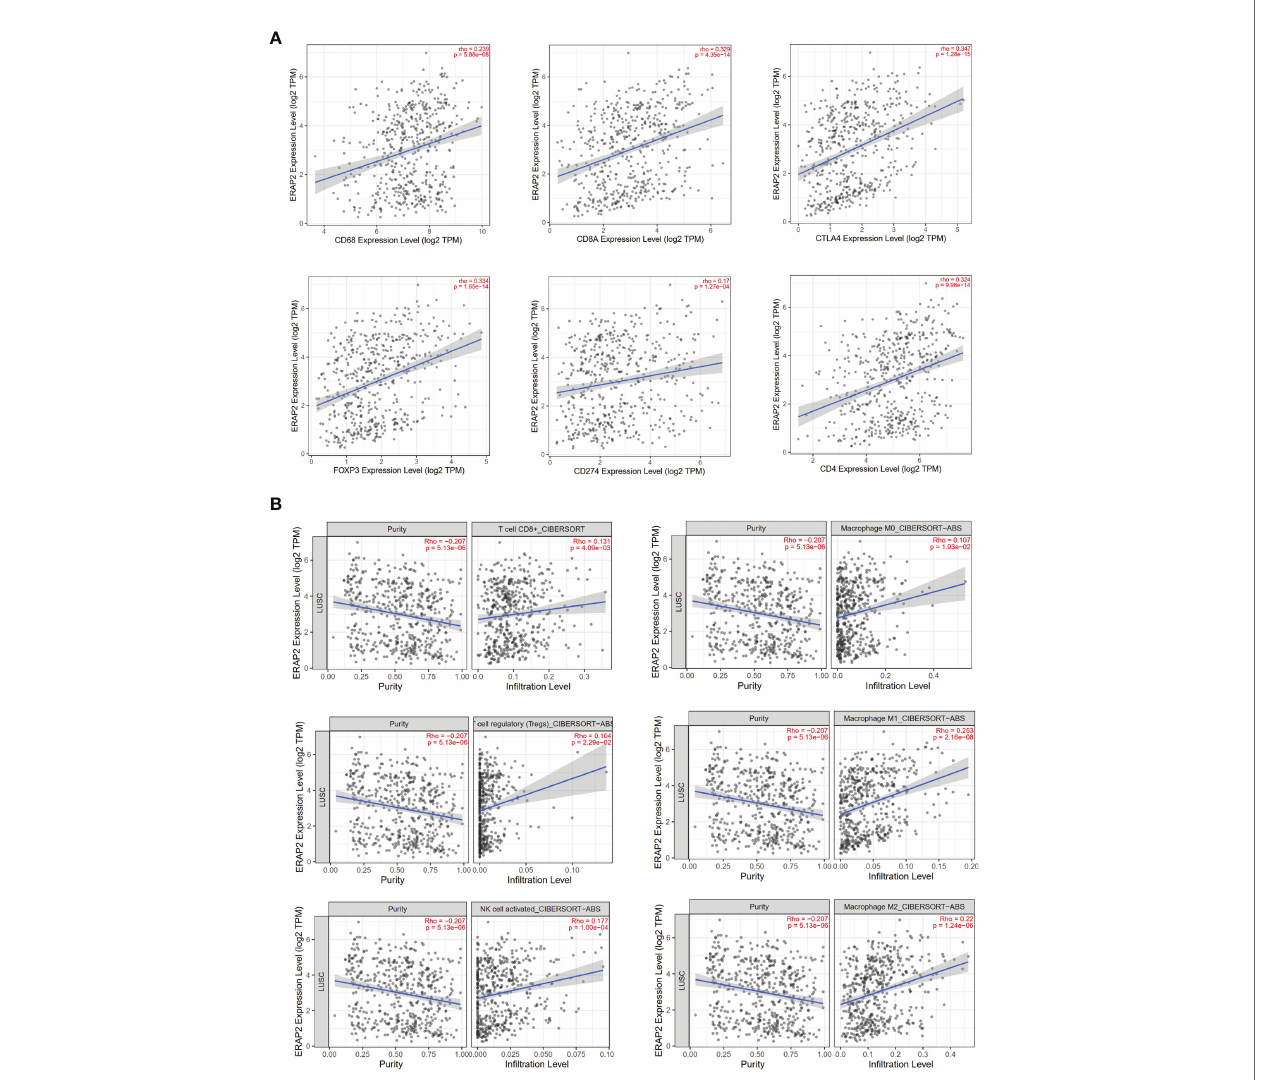
FIGURE 5 | Immune associations about ERAP2 expression using public data (TIMER). (A) Correlations between the expression of ERAP2 and immune markers in SqCLC. Top: CD68, CD8A, CTLA4. Bottom: FOXP3, CD274, CD4. The correlation coef fi cient and p-value are in the top right corner of each picture. (B) Correlations between ERAP2 expression and immune cell in fi ltration level in SqCLC. Top CD8+ T cell, M0 macrophage. Middle: regulatory T cell regulatory, M1 macrophage. Bottom: Activated NK cell, M2